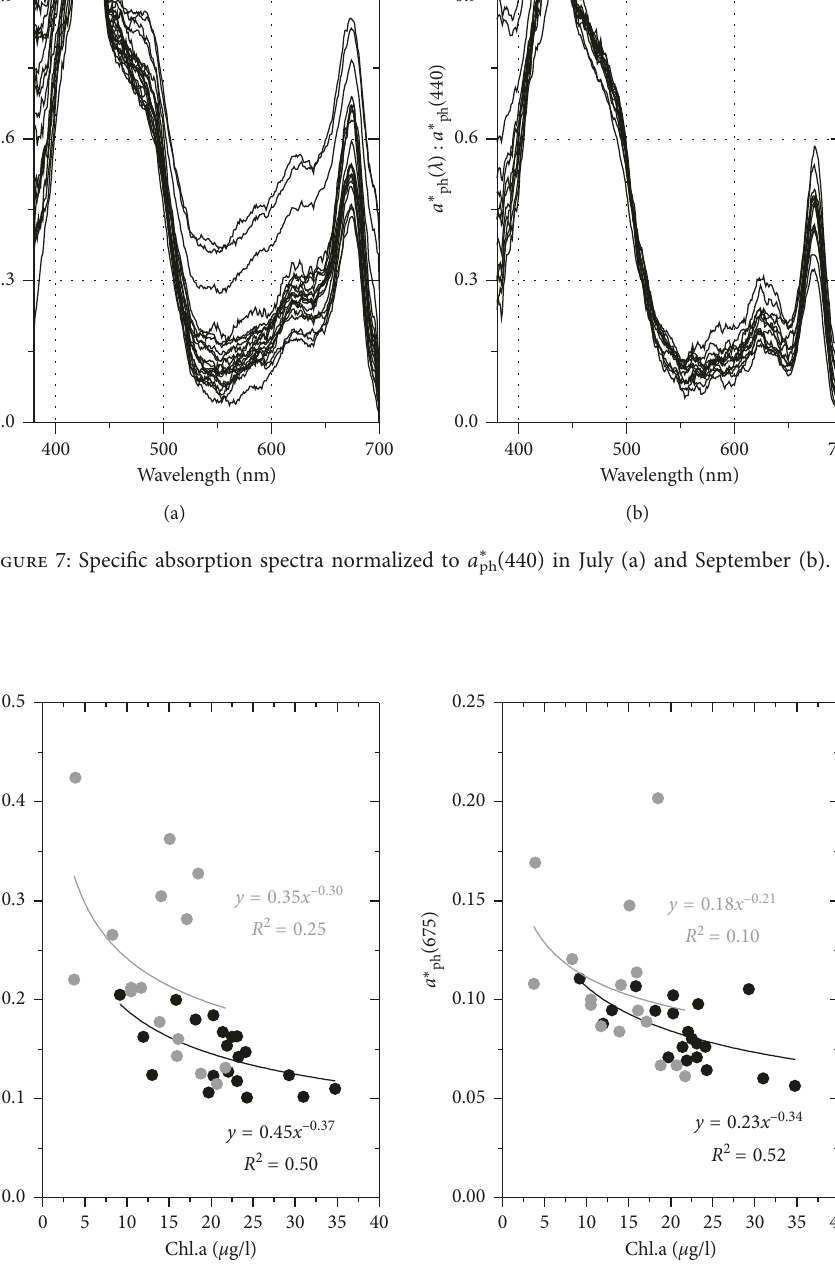
ph (440), a ph (675), and Chl.a. ∗ ∗